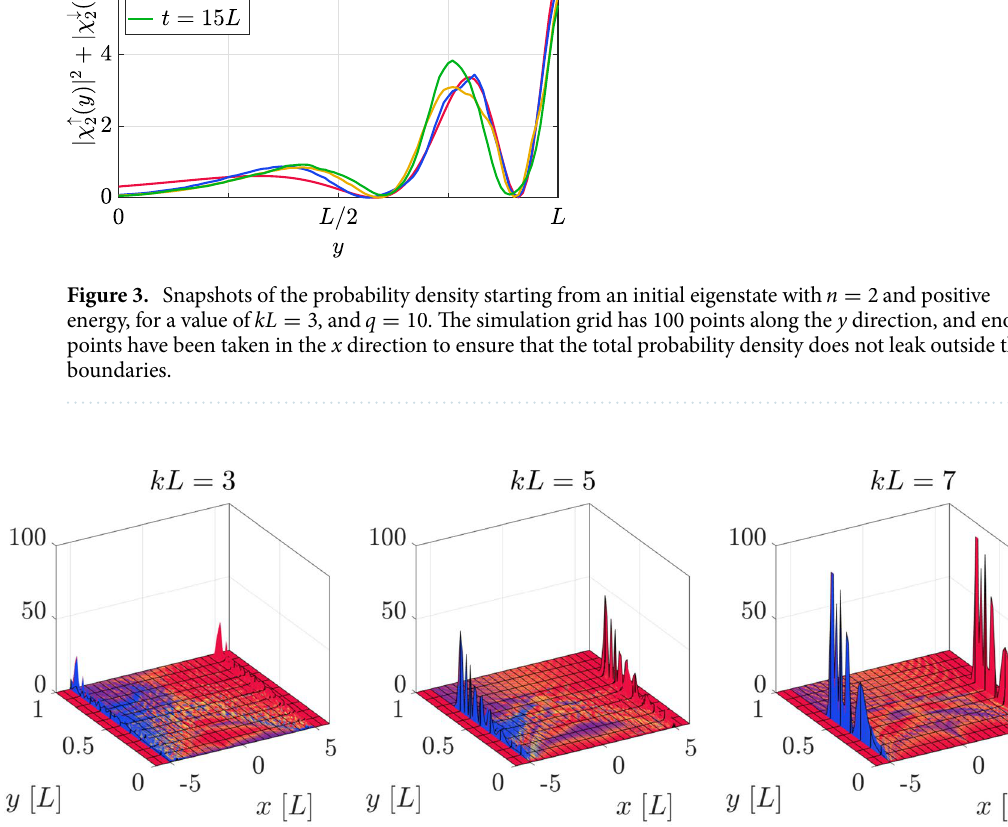
Figure 4. Probability density distribution, at t for different values of kL with initial coin components C 0 probability of finding the walker in that position, and the colors indicate the coin state. The red (blue) color indicates a predominance of the upper (lower) component, while yellow stands for a superposition of both components. The simulation grid has 100 points along the y direction, and enough points have been taken in the x direction to ensure that the total probability density does not leak outside the